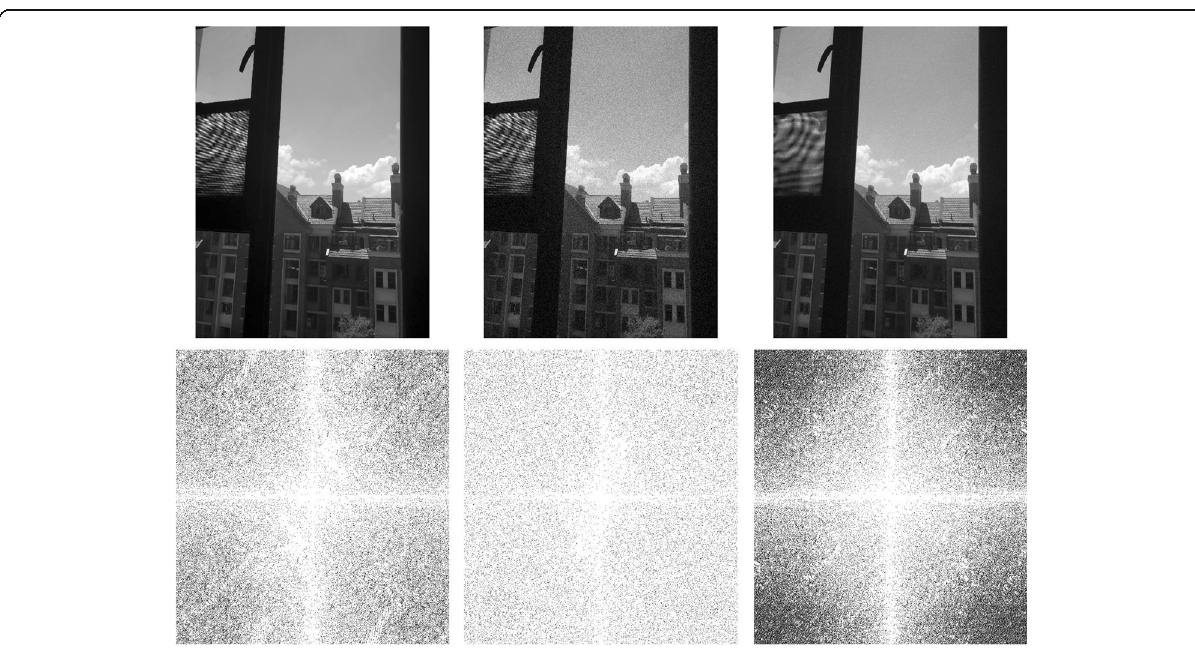
Fig. 1 Image denoising results comparison. (The first row from left to right are the original image, plus the noise map and the filtered map. The second row from left to right are the frequency distribution of the original image, the frequency distribution of the noise plus the filtered Frequency